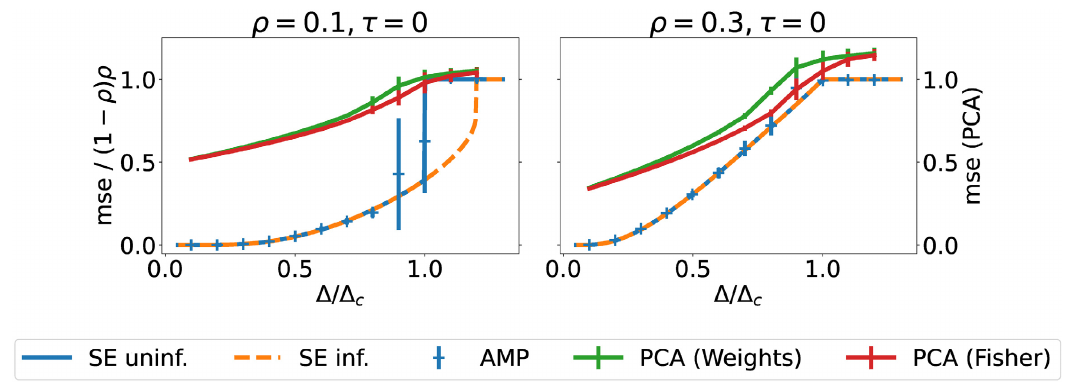
Fig 3. Performance of various algorithms when reconstructing a pattern with low coding level following Tsodyks’ prior. (Top) Same plot as Figs 1 and 2, for a single stored pattern drawn from Tsodyks’ prior (24). For ρ < 0.211, the performance of the algorithm with random initialisation (15) is different from the performance with informed initialisation (16), which might be the signature of a hard phase. Parameters: τ = 0, N = 5000 for AMP, N = 20000 for PCA.